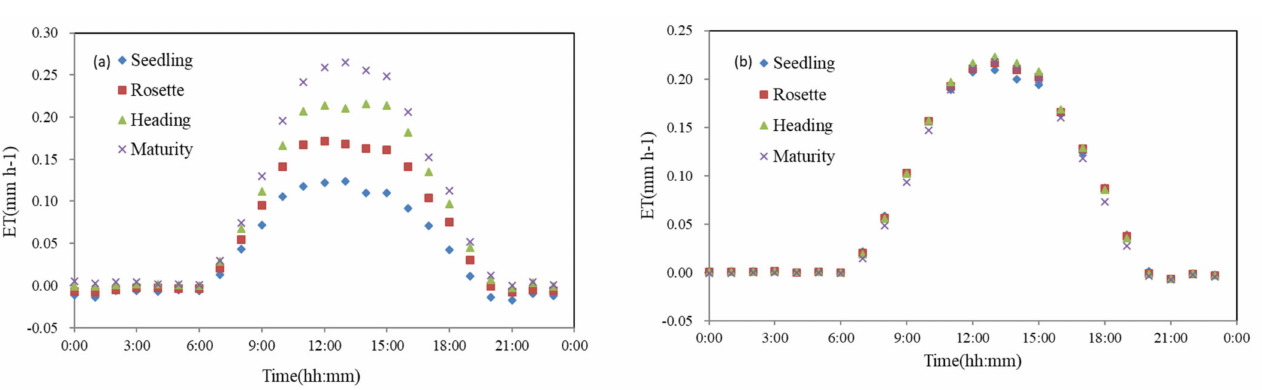
Figure 3. ( a ) Diurnal ET variation of Chinese cabbage at different growth stages of the first crop; ( b ) diurnal ET variation of Chinese cabbage at different growth stages of the second